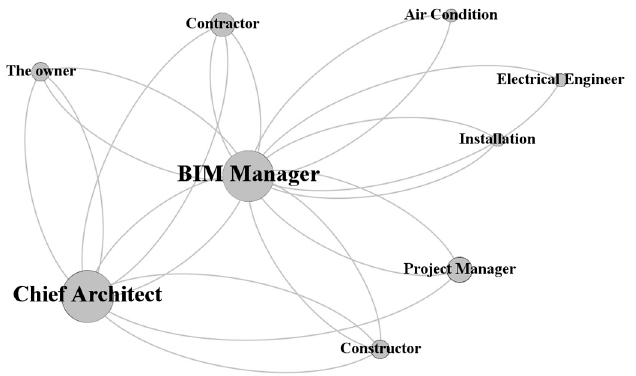
Figure 5. A graphical presentation of Model 3.